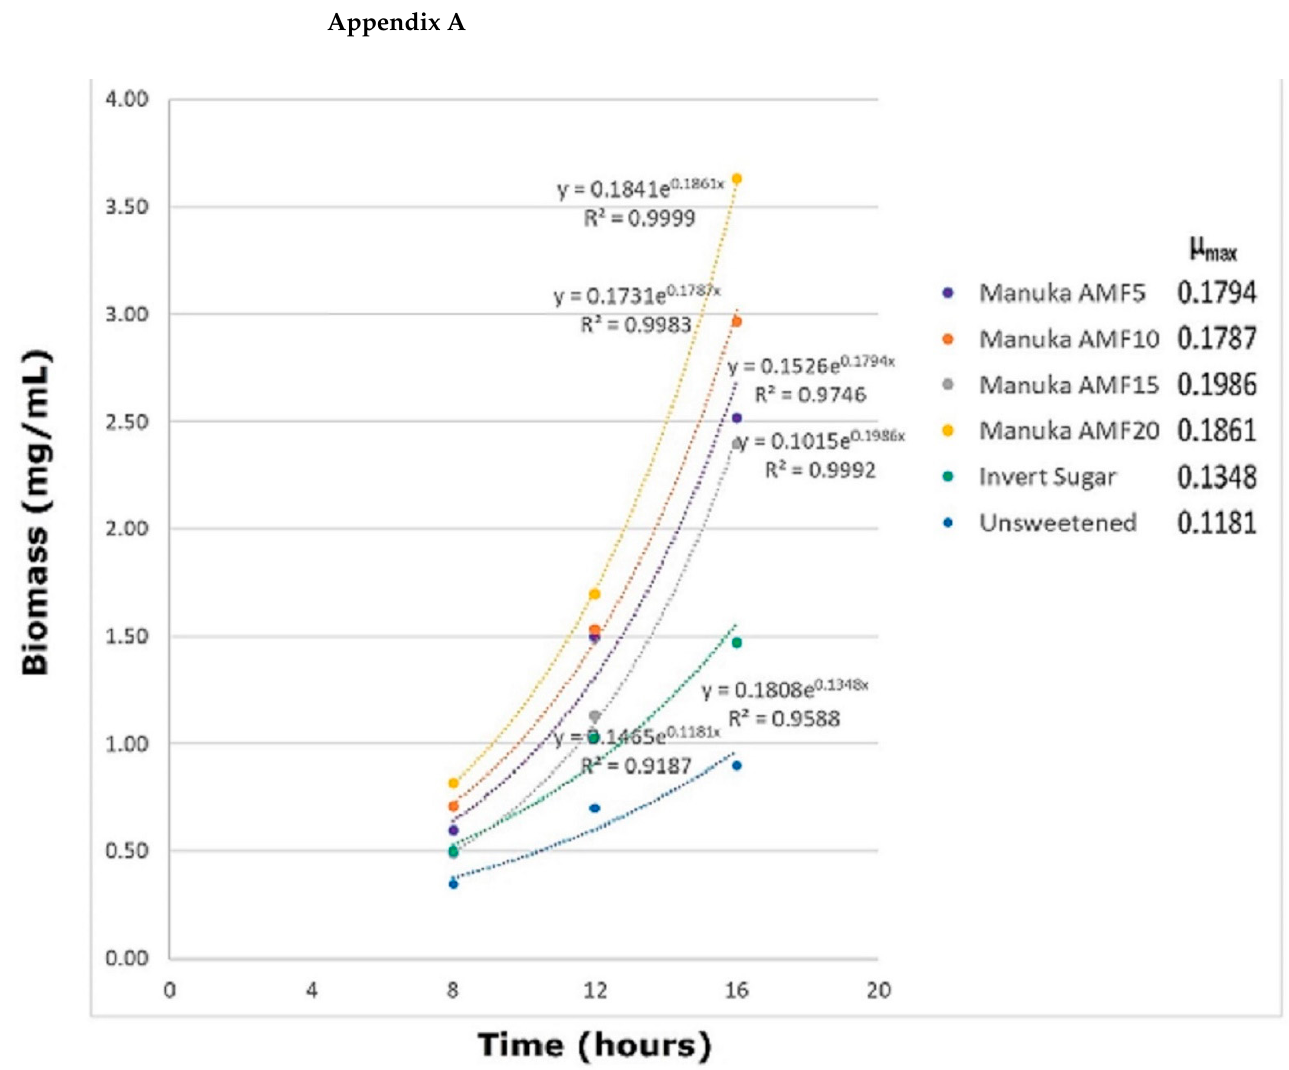
Figure A1. Fermentation kinetics for biomass (mg/mL) of L. reuteri DPC16 in fermented MRS broth with Manuka honey (AMFTM 5 + , 10 + , 15 + and 20 + ), invert syrup and unsweetened control during the exponential growth period (8–16 h). µ max denotes the ‘maximum specific growth rate’ for each sample.